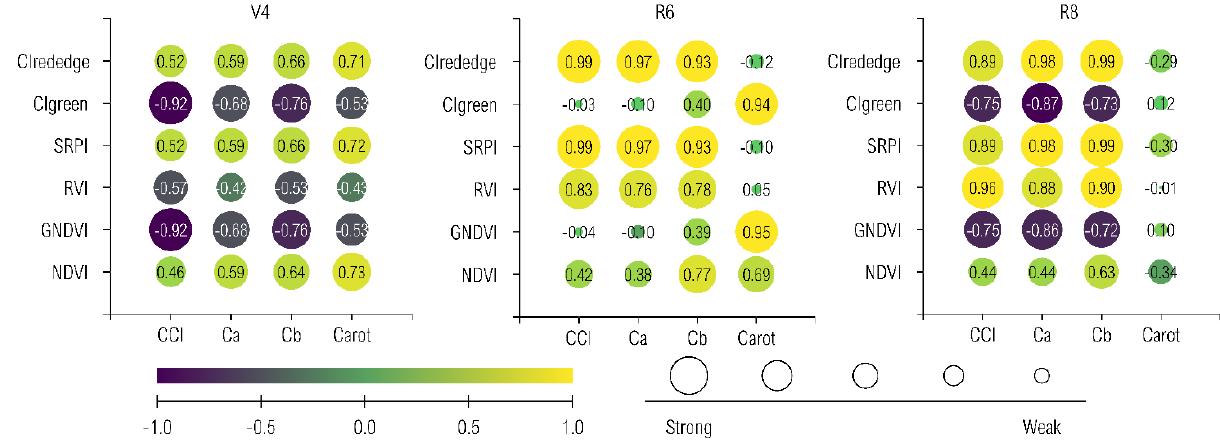
Figure 6. Explanatory relationships between vegetation indices; Chlorophyll content index, CCI; chlorophyll a , Ca; chlorophyll b , Cb; and Carotenoids, Carot. chlorophyll a , Ca; chlorophyll b , Cb; and Carotenoids,